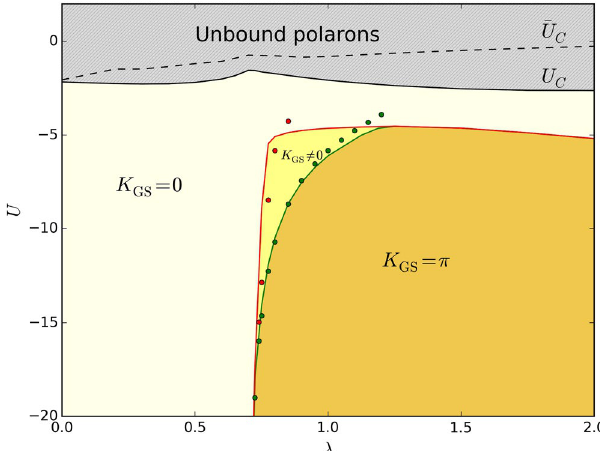
Figure 1. Two-polaron phase diagram at t = 1, Ω = 3. The solid black line shows U C ( λ ) below which stable bound states form, while the dashed line shows λ U ( ) ; the difference between the two is the strength of the C phonon-mediated interaction. Note that < U U , which means that this interaction is repulsive. The red and C C green lines mark the sharp transitions of the bound dimer’s GS. The lines are the VED results and the corresponding symbols are the MA